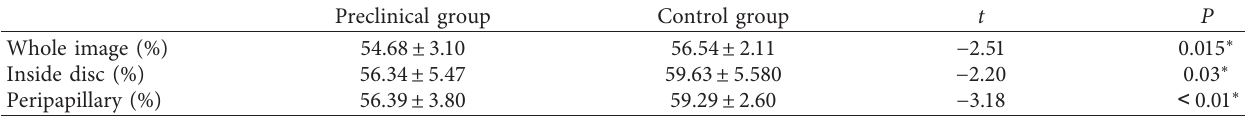
Table 2: Vessel density in the preclinical group and control group.